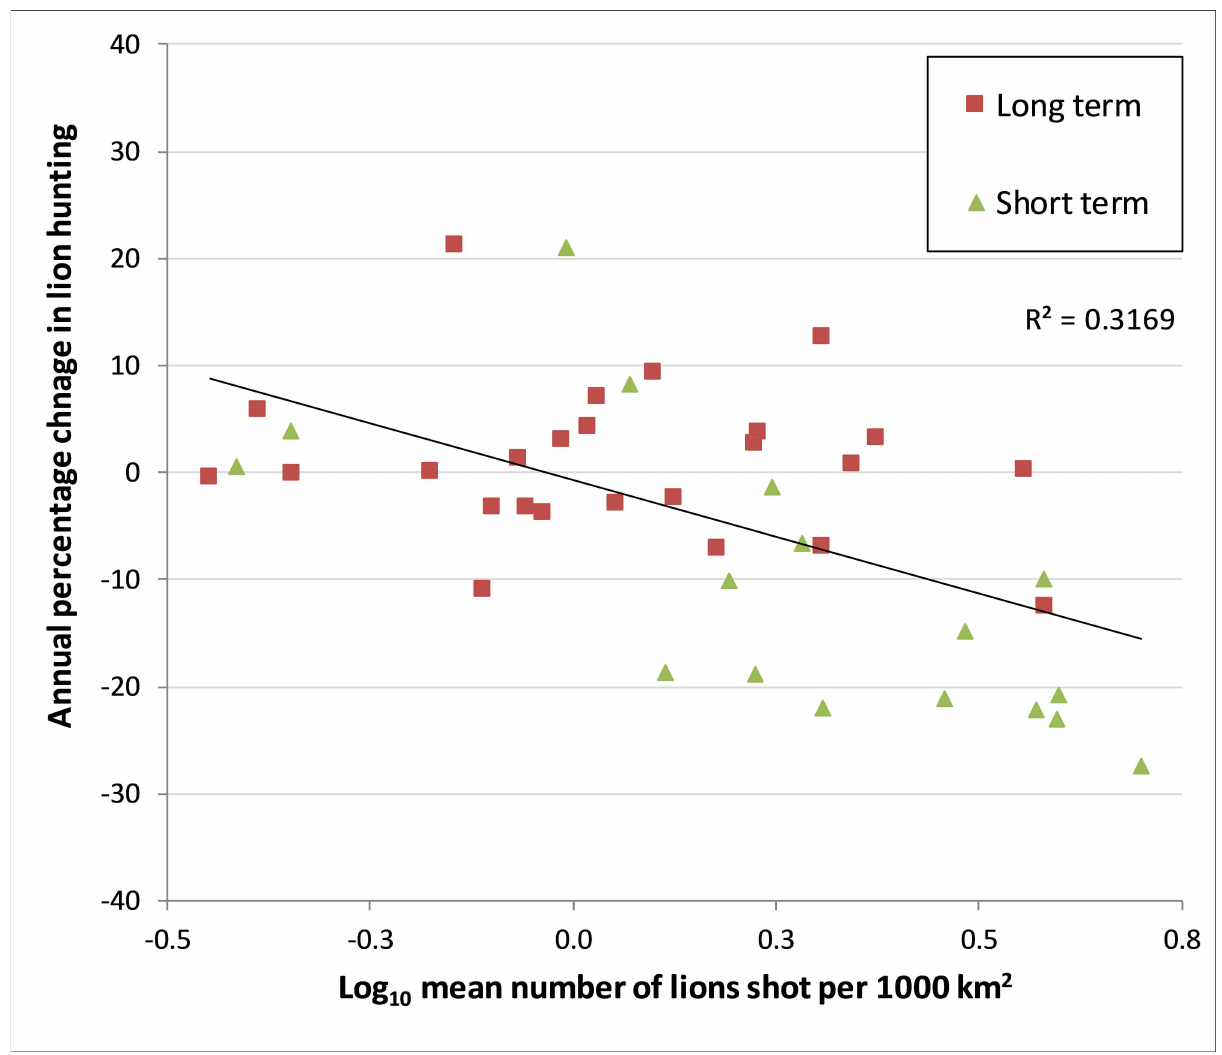
Fig 4. Long-termversus short-termtenurein SelousGame Reserve,shown as the annualrate of changein huntingofftake(%) and lion